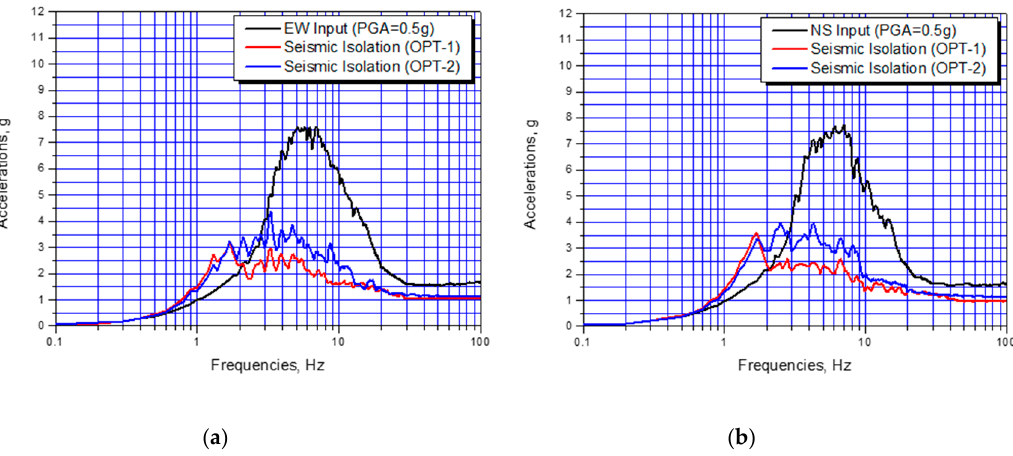
Figure 8. Response spectrum for PGA = 0.5g: ( a ) EW direction; ( b ) NS direction.